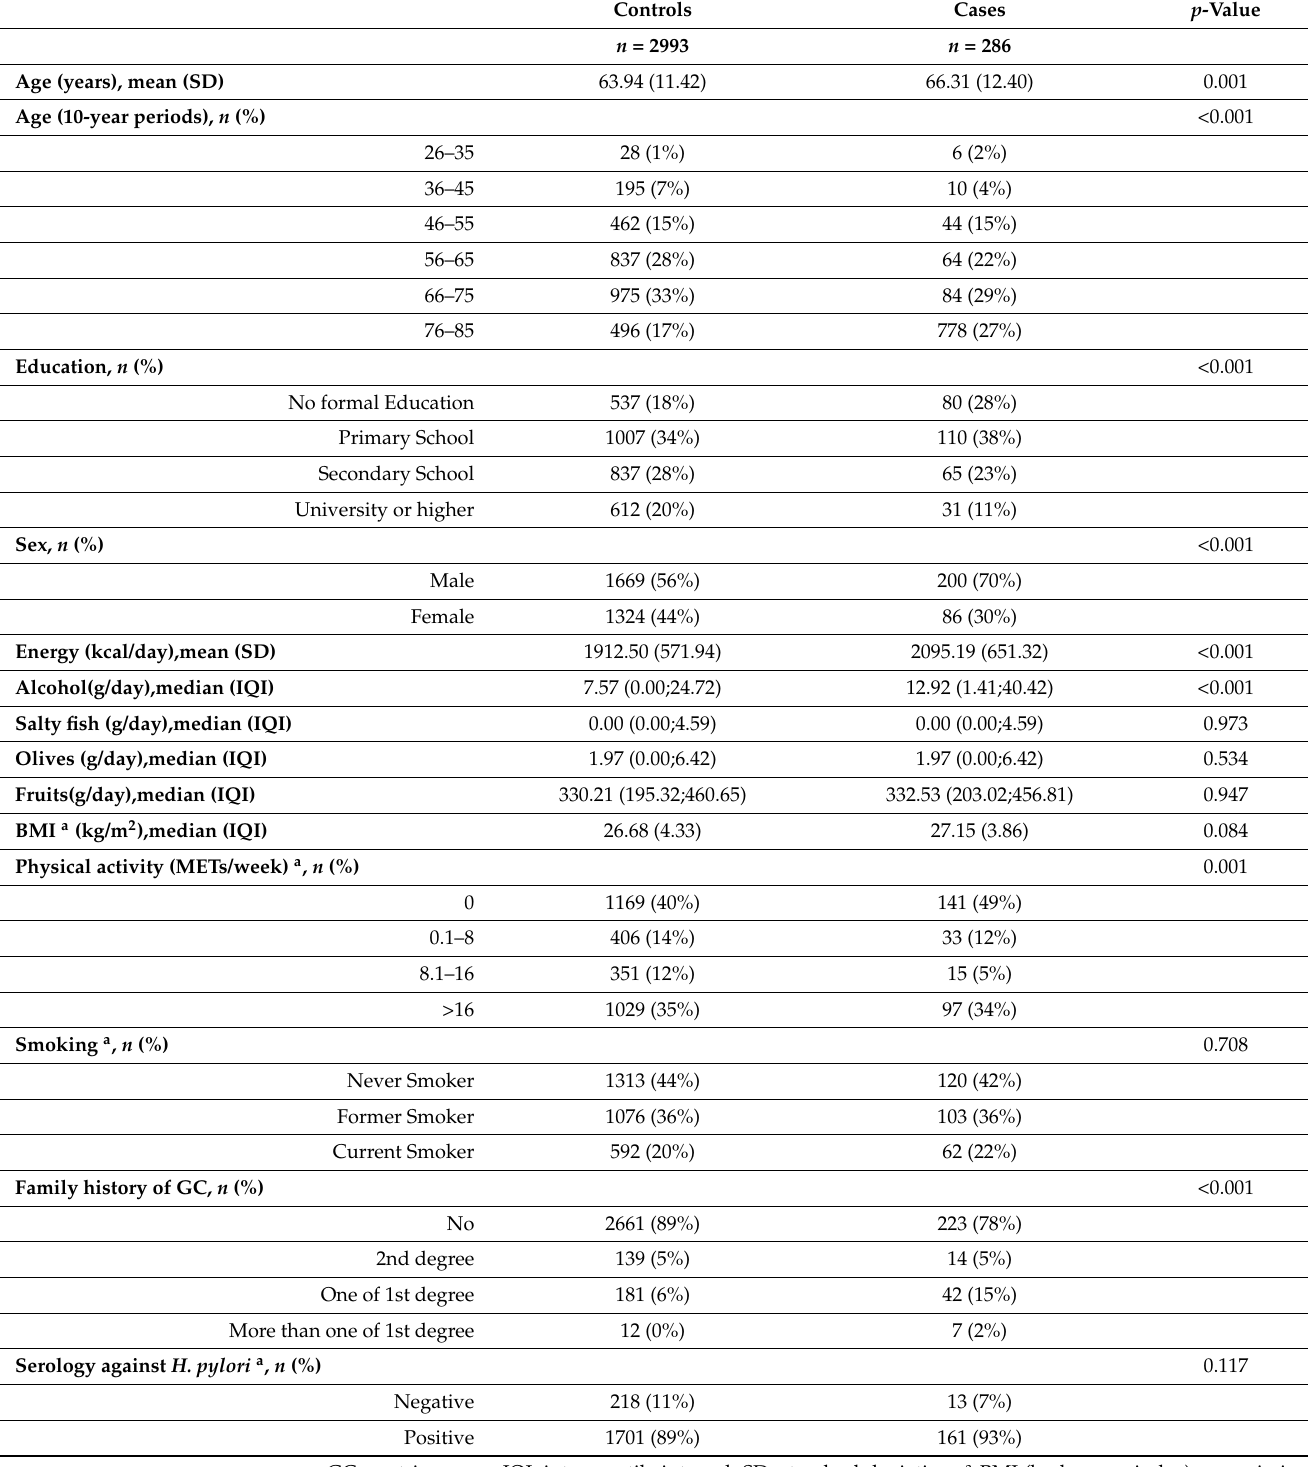
Table 1. Description of socio-demographic and other baseline characteristics of controls and gastric adenocarcinoma cases in the MCC-Spain